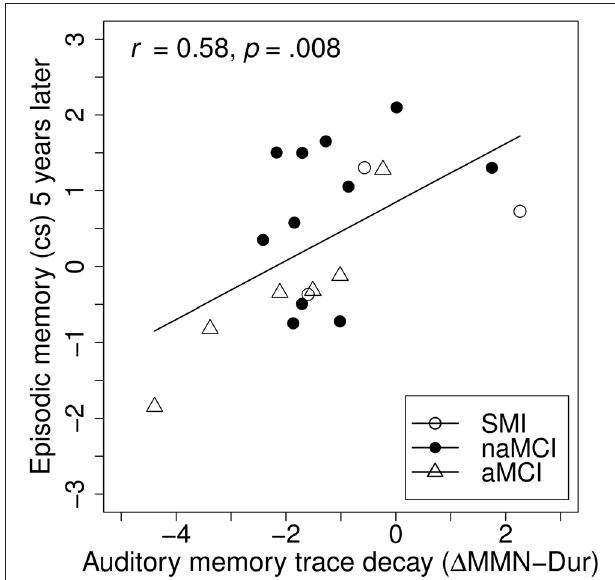
FIGURE 5 | Associations between baseline auditory memory decay and follow-up episodic memory. Auditory memory reflected by the difference score between MMN amplitude after duration deviant in the Opt1 paradigm and the MemTra paradigm ( ∆ MMN–Dur), higher scores indicating less auditory memory trace decay. Opt1, Optimum–1; MemTra, Memory Trace, cs, composite